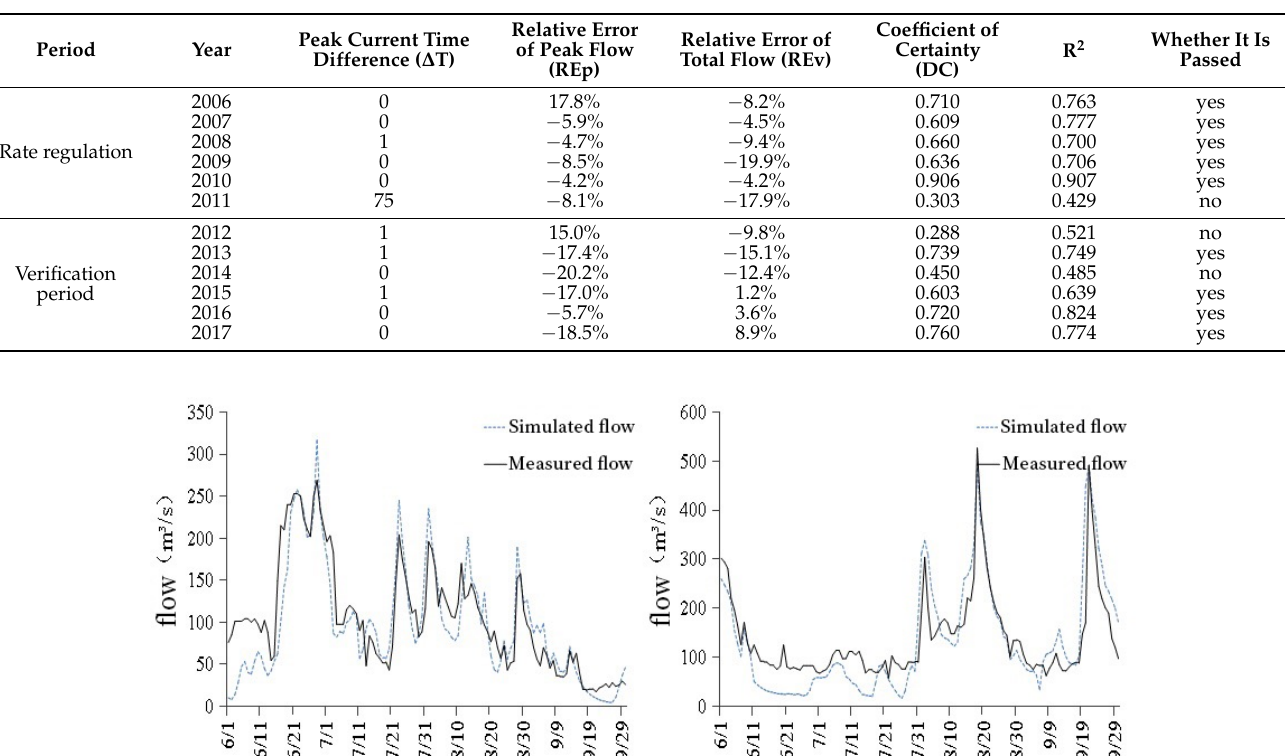
Table 3. Simulation results of HEC-HMS model.